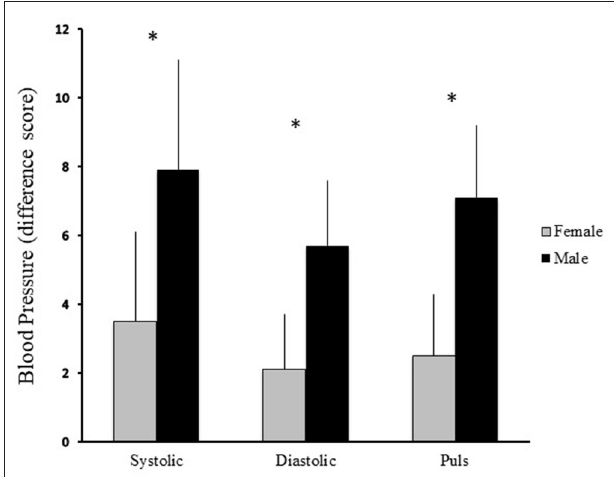
FIGURE 2 | Mean difference scores and Standard Error of Mean (SEM) on the blood pressure between pre and post-test for systolic, diastolic and pulse after the 10min online slot machine task between men (black bars) and the women (gray bars). The asterisks denote significant differences between pre and post-test ( p < 0.05) for the data of the whole